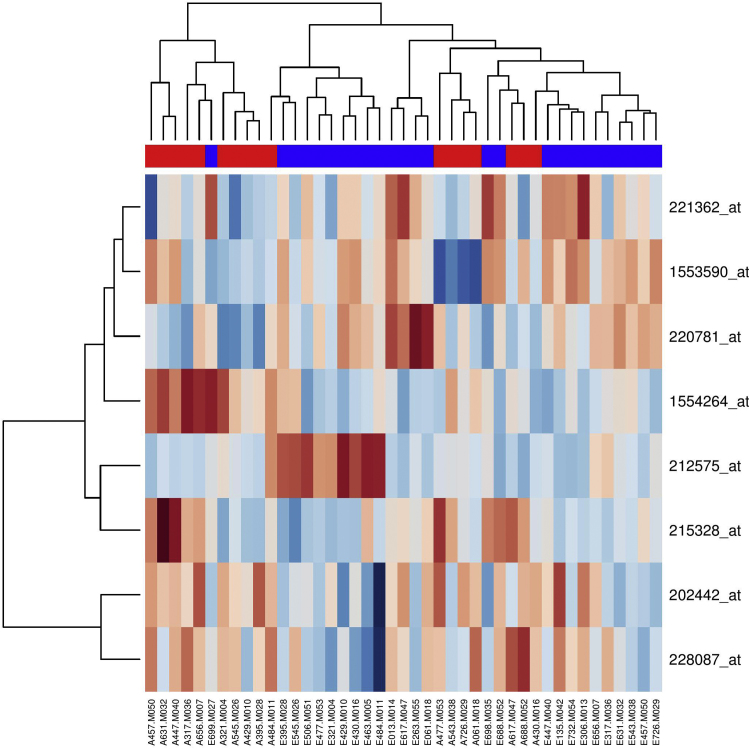
Heatmap and dendrogram of the differential gene expression profiles for the eight gene markers generated from unmatched pre-MAP and post-MAP intervention samples using MAS5.0 normalization before FDR correction. The pre-intervention group is colored in blue and post-intervention group is in red. The relative expression level of each gene among all the tested samples have been assigned sequentially from dark red color to dark blue color in accordance with low to high expression level.